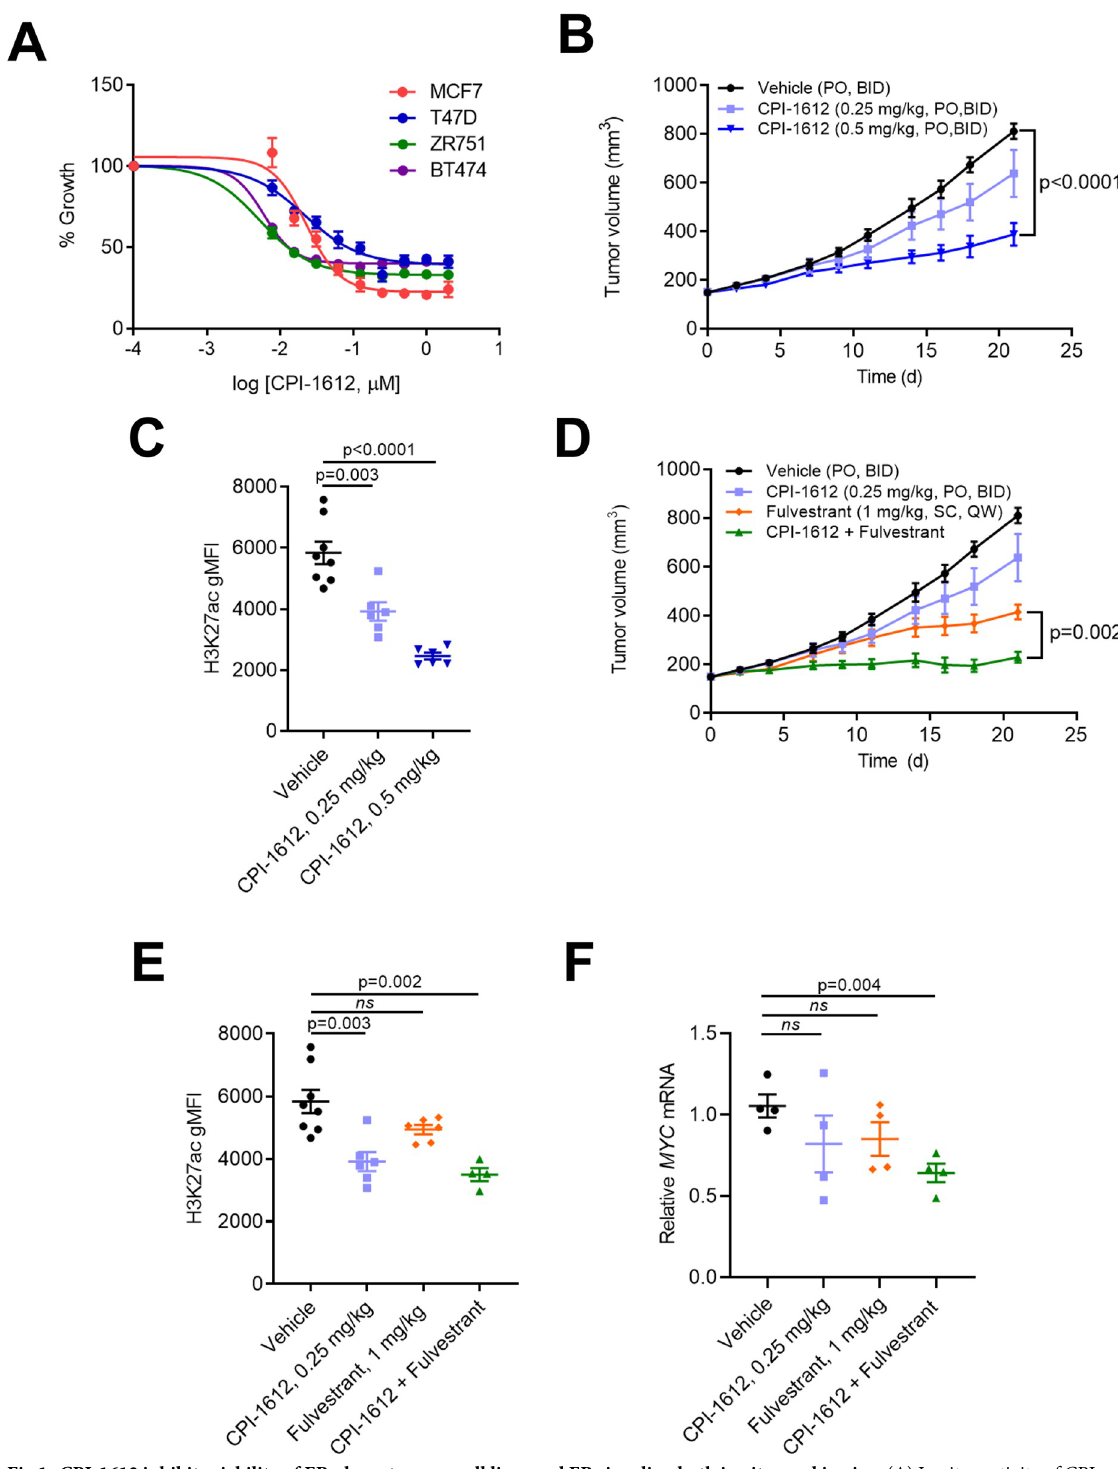
Fig 1. CPI-1612 inhibits viability of ER+ breast cancer cell lines and ER signaling both in vitro and in vivo. (A) In vitro activity of CPI- 1612. ER+ breast cancer cell lines were treated with increasing doses of CPI-1612 and cell viability was measured using Cell Titer Glo after 4 days of treatment. Error bars represent standard deviation (n = 2). (B) In vivo activity of single agent CPI-1612. Female Balb/c nude mice were implanted subcutaneously with MCF7 cells (n = 8 for vehicle, n = 6 for others) and treated with the indicated doses of CPI-1612 (PO, BID) or an equal volume of vehicle (PO, BID). Tumor volumes were measured by caliper until study termination at 21 days. Data points